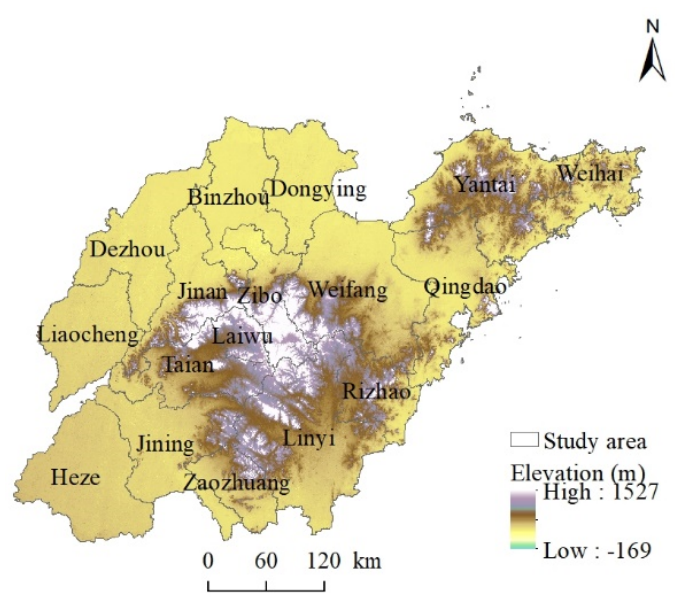
Figure 1. Location of Shangdong Province, China.